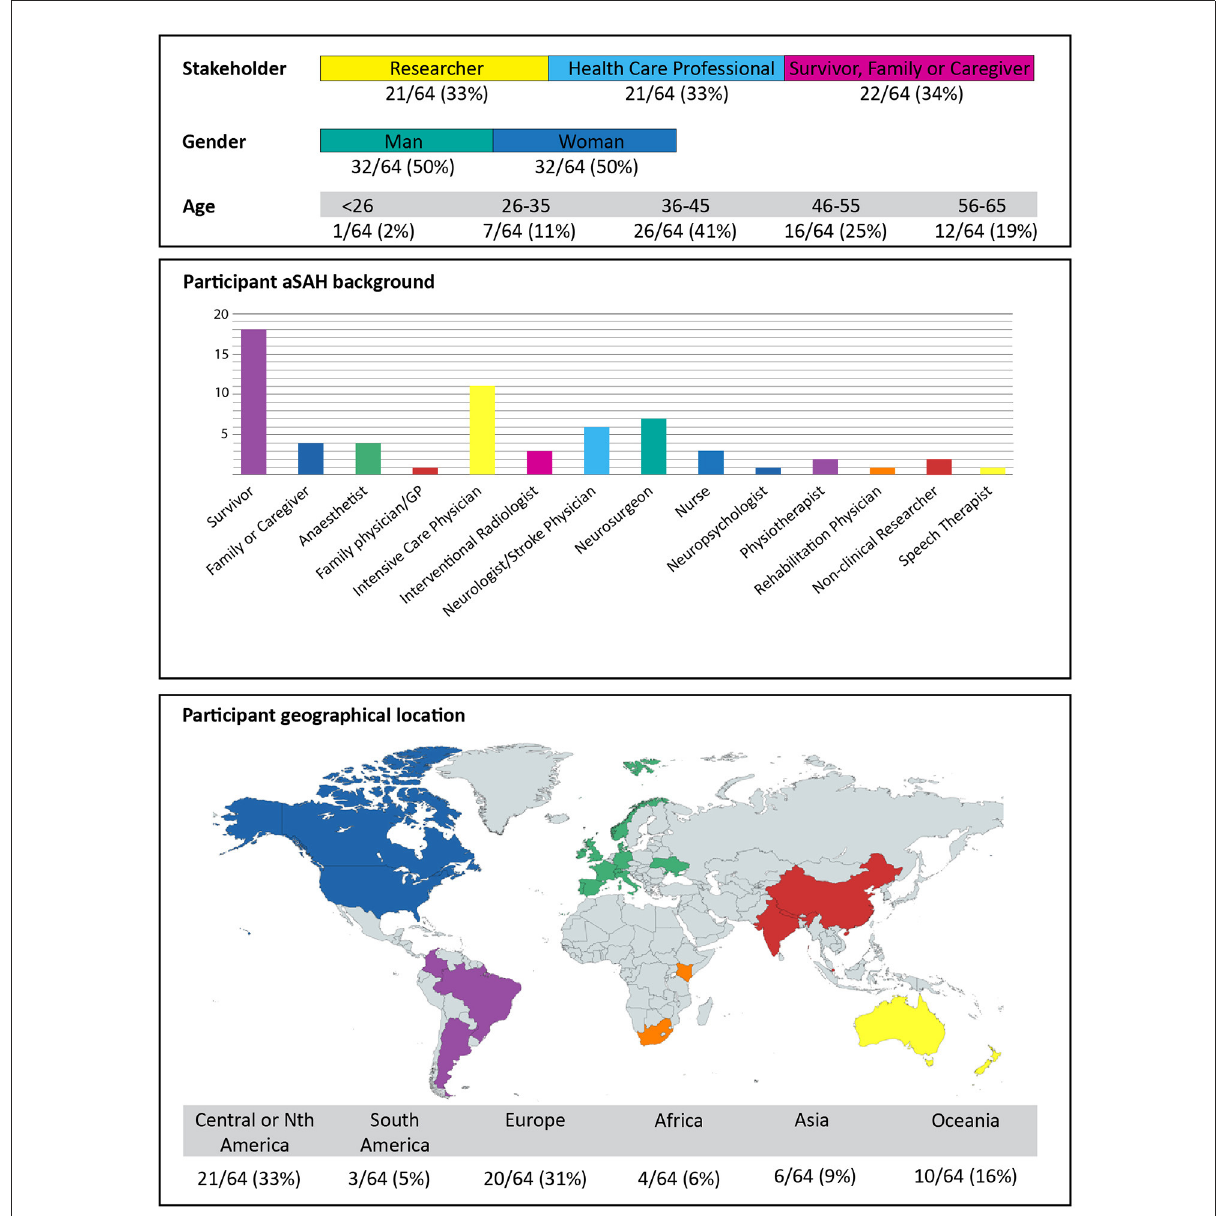
FIGURE2 Participant